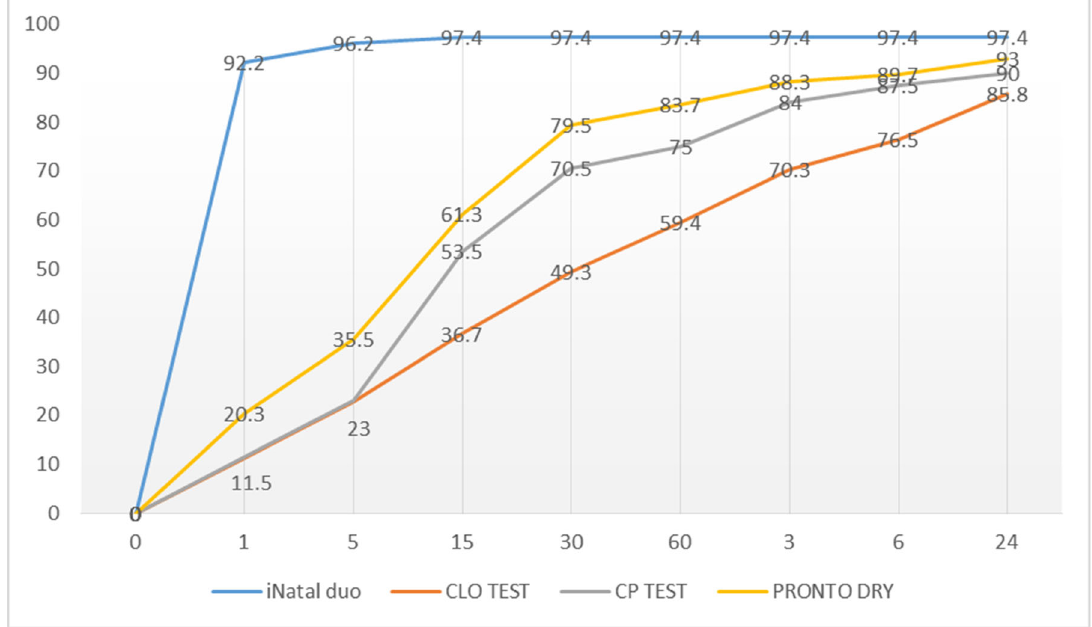
Figure 1. Sensitivity of the rapid urease tests (RUTs) at the different time points evaluated. Sensitivity rates (%) are expressed for the different RUTs. Table 1. Number of Hp ‐ positive patients (not taking PPIs) for RUTs at different time points. The total of Hp ‐ positive patients at histologic examination was 225/924 (24.3%). Statistical comparison has been made by one ‐ way ANOVA test and p values are reported.